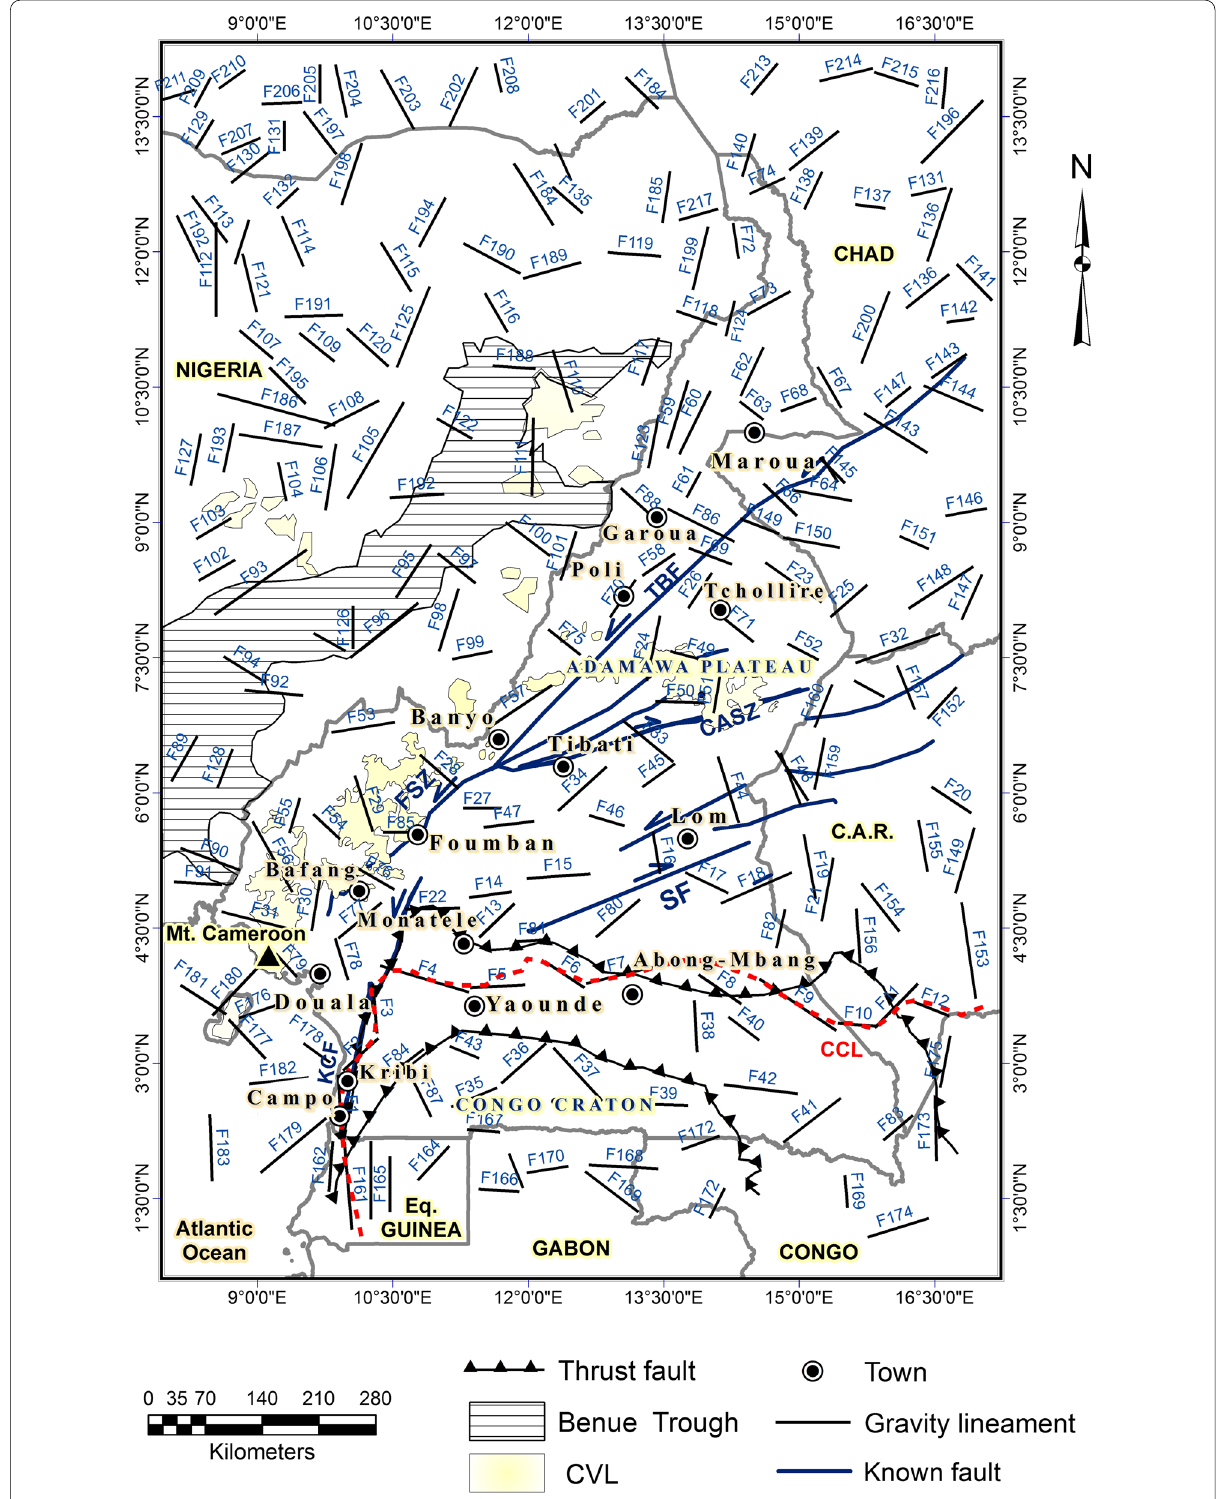
Fig. 8 Lineaments map derived from the Bouguer